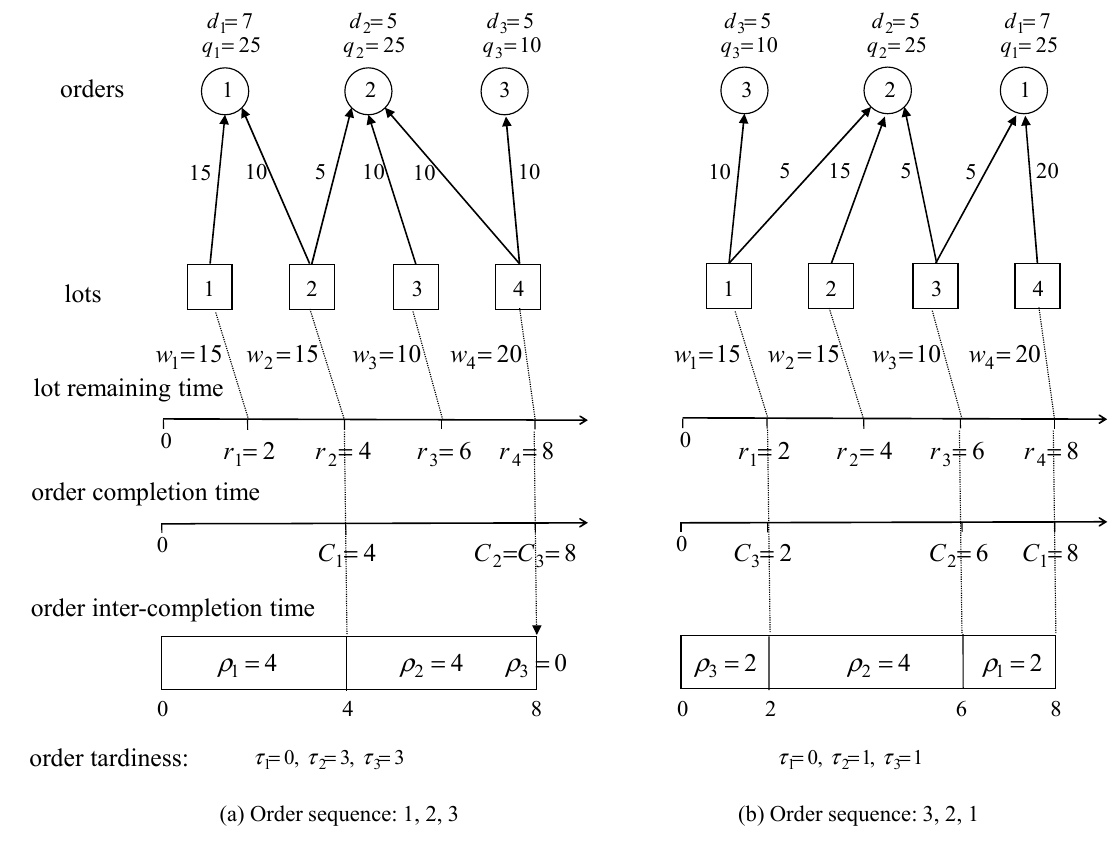
Figure 1. Order-lot matchings using the compact pegging method.